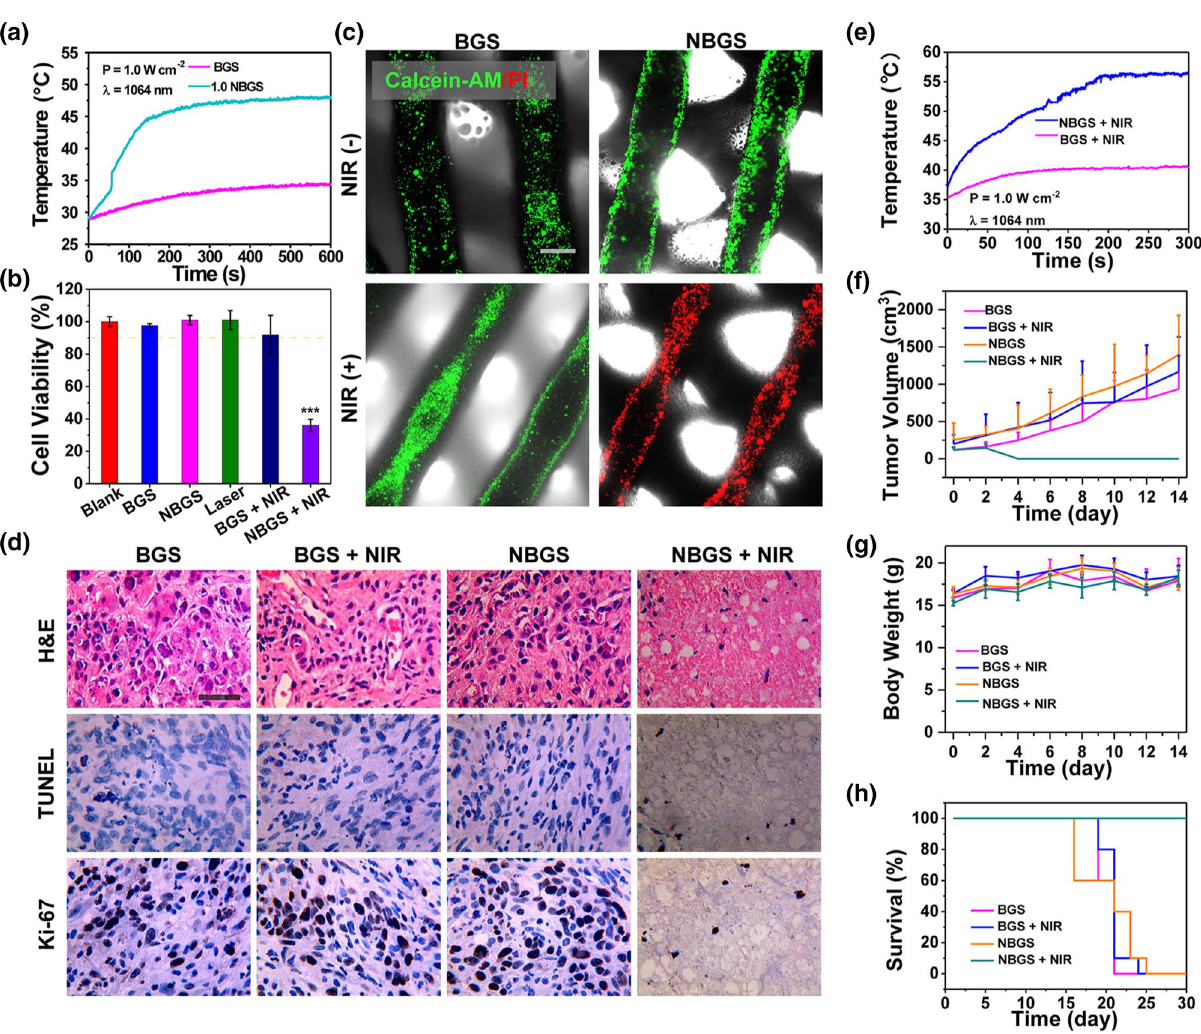
Fig. 3 Photothermal property of BGS/NBGS and their antitumor capacities both in vitro and in vivo. a Temperature-change curves of 1.0 NBGS and BGS in PBS. b Relative cell viabilities of Saos-2 cells after various treatments. c CLSM images of all treatment groups (BGS, BGS + NIR, NBGS, NBGS + NIR) including bright-field images. Calcein AM/PI co-stained images indicated live/dead cells adhering on the scaffold. d Optical microscopy images of tumor tissues stained by hematoxylin and eosin (H&E), TdT-mediated dUTP nick-end labeling (TUNEL) and Ki-67. e Temperature curves of the tumor implanted with 1.0 NBGS and BGS in the mice model followed by NIR-II laser irra- diation. f Tumor volume of osteosarcoma-bearing mice with different treatment protocols (n = 5). g Body weight of osteosarcoma-bearing mice (n = 5). h Survival curves of mice in different treatment groups (n = 5). The scale bar represents 500 mm ( c ) and 100 mm ( d ). (Color figure